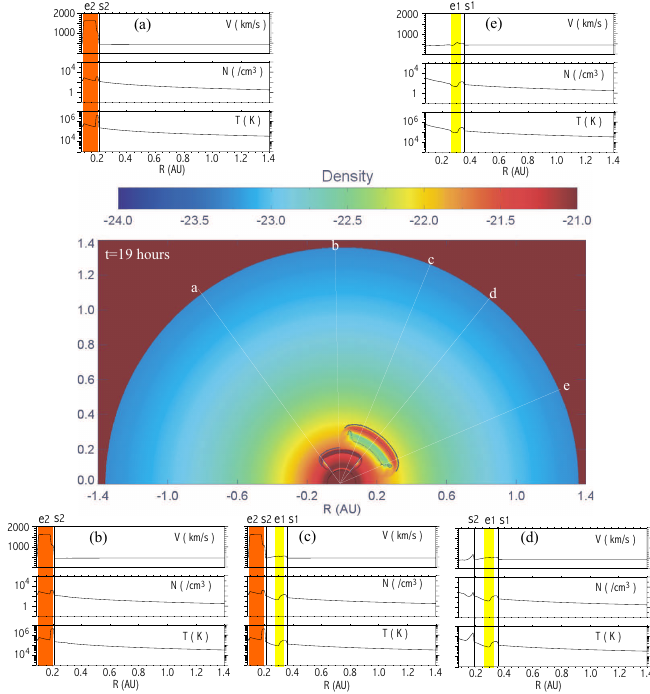
Fig. 6. Two-dimensional simulation. Snapshot of density logarithmic contours showing the evolution of the two ejecta at 19h after ejecta 1 initiation. The five plots ( a , b , c , d , e ) show radial cuts of solar wind parameters at different angles denoting the ejecta (solid cases) and their shock waves (dotted lines).